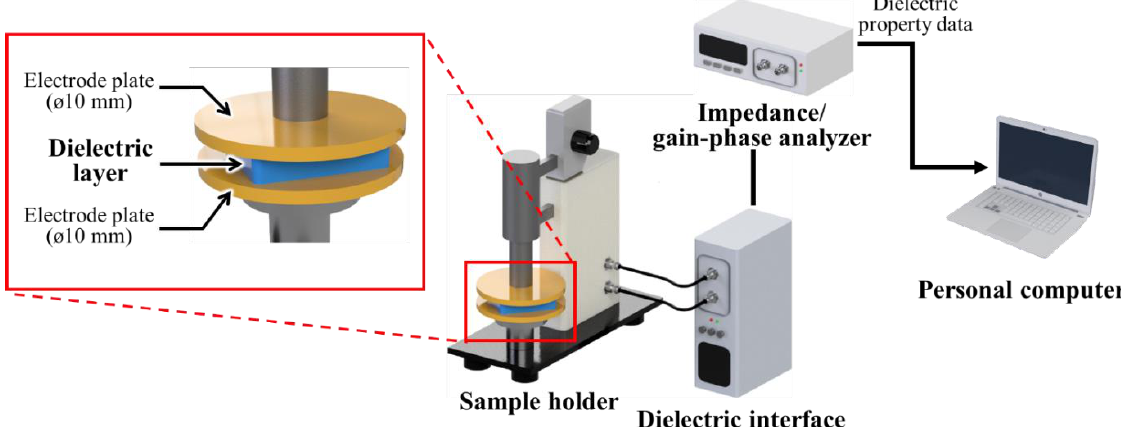
Figure 6. Experimental environment used to investigate the dielectric properties of the dielectric layer samples.